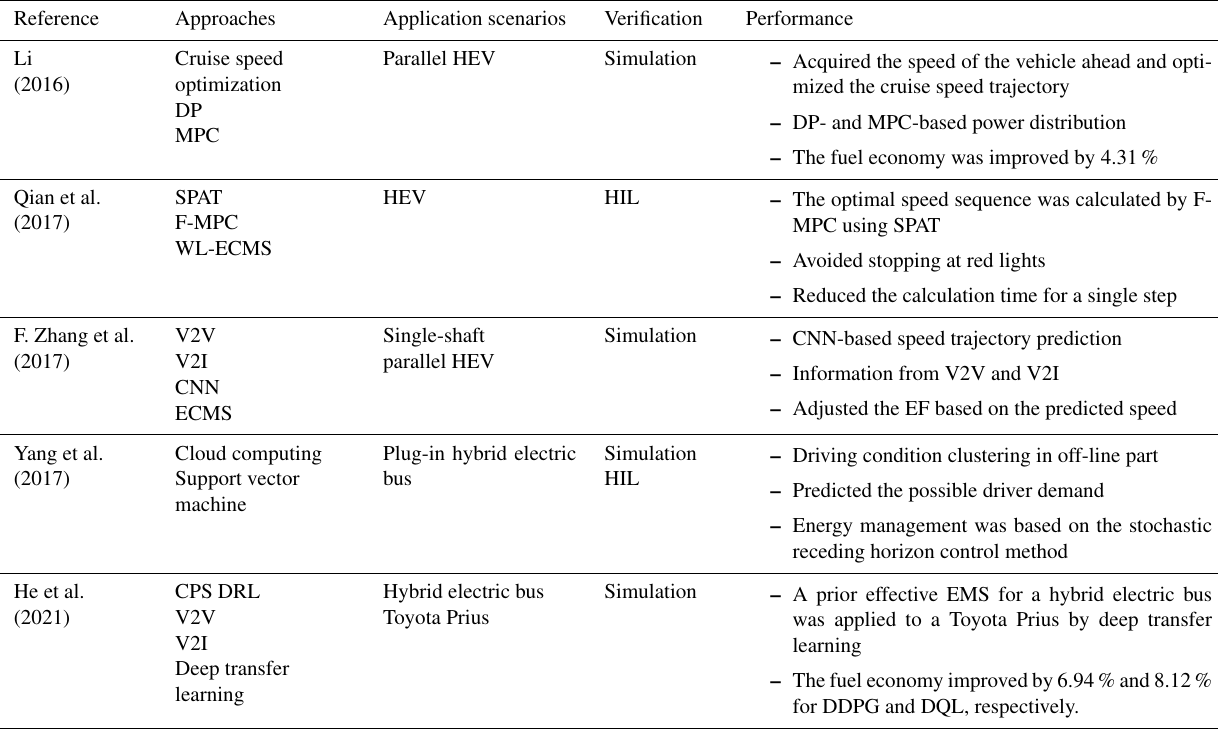
Table 16. Summary of exemplary works on ITS-based EMSs established using static data.